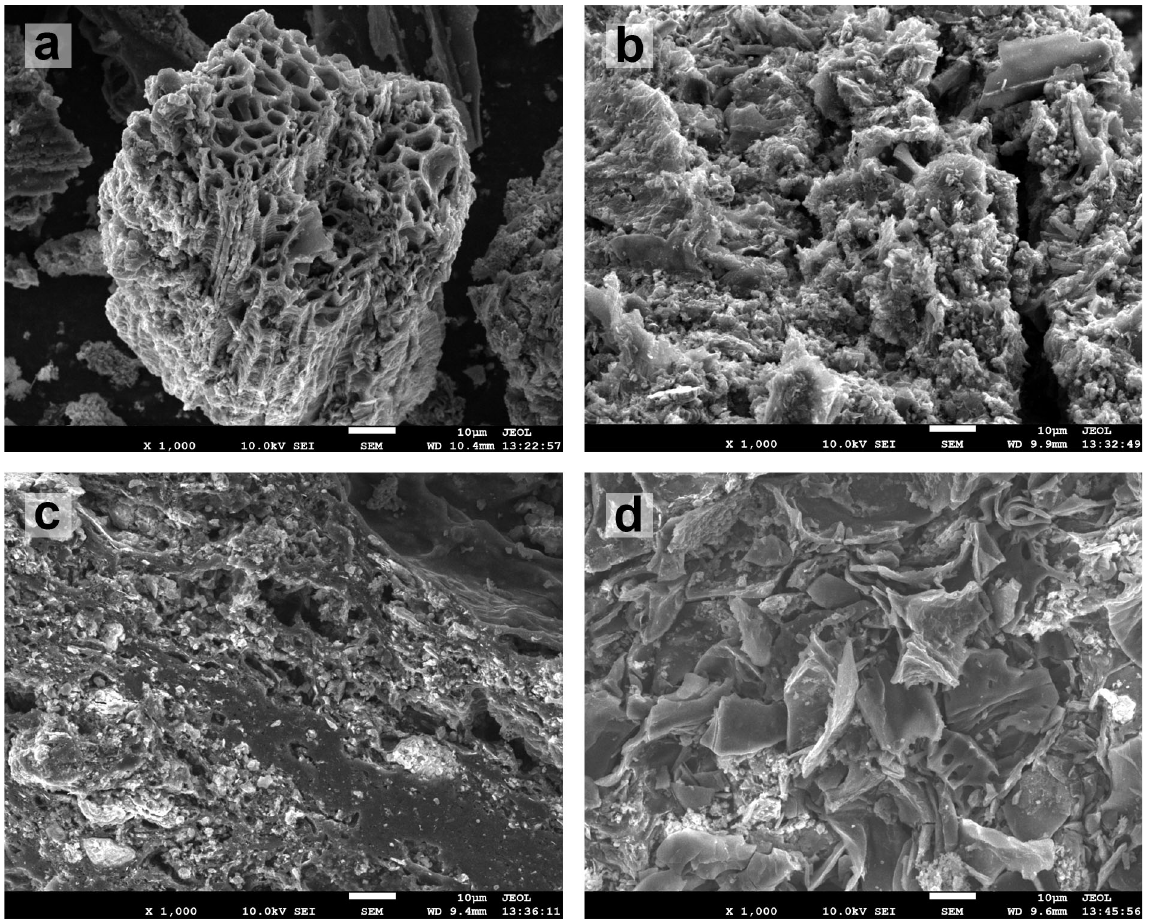
Fig. 3. SEM analysis of ACs, a - Aduunchuluun, b - Shivee Ovoo, c - Ulaan Ovoo, d - Baganuur